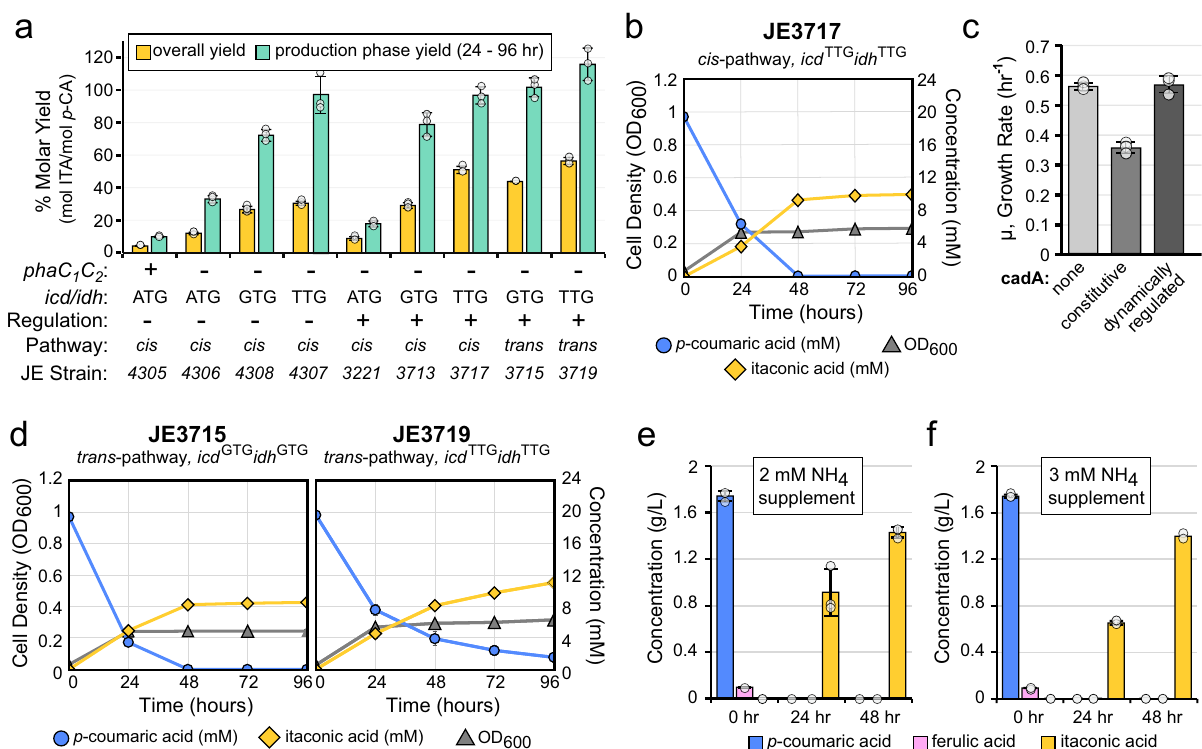
Fig. 4 Biosensor-controlled expression of itaconic acid production pathways enables high yield production from lignin and model aromatic substrates. a Molar yield of engineered strains from shake fl ask experiments with 20 mM p- coumaric acid as sole carbon source. Overall yield (yellow) and production phase yield (green) are indicated. Production phase was de fi ned as 24 hr to 96 hr time points. Relevant genetic modi fi cations include the presence ( + ) or deletion ( − ) of the native PHA polymerase genes phaC 1 C 2 , the start codon used (ATG, GTG, or TTG) for isocitrate dehydrogenase genes icd and idh , use of a constitutive ( − ) or dynamically regulated ( + ) itaconic acid biosynthesis pathway, the cis - or trans - itaconic acid production pathway, and the corresponding stain name. ( b,d ) Production of itaconic acid from p- coumaric acid in shake fl asks by strains utilizing dynamically-regulated ( b ) cadA (cis- pathway) or ( d ) tad1 / adi1 (trans-pathway) under nitrogen-limited conditions. Strain names and their unique modi fi cations are indicated above the charts. Cell density (OD600, gray diamonds), p- coumaric acid (mM, blue circles), and itaconic acid (mM, yellow triangles) are indicated. c The effect of cadA expression on growth of P. putida icd TTG idh TTG strains in 48-well microtiter plate assays with p- coumaric acid as sole carbon source. Consumption of detected aromatic monomers and production of itaconic acid from depolymerized lignin containing either ( e ) 2 mM or ( f ) 3 mM supplemented NH 4 Cl in shake fl ask cultivations with strain JE3715. a − f Data are represented as the mean ± standard deviation in three replicates, with the exception of 48 h time point in panel f , which only contains two replicates and has no error bars. Source data are provided as a Source Data fi